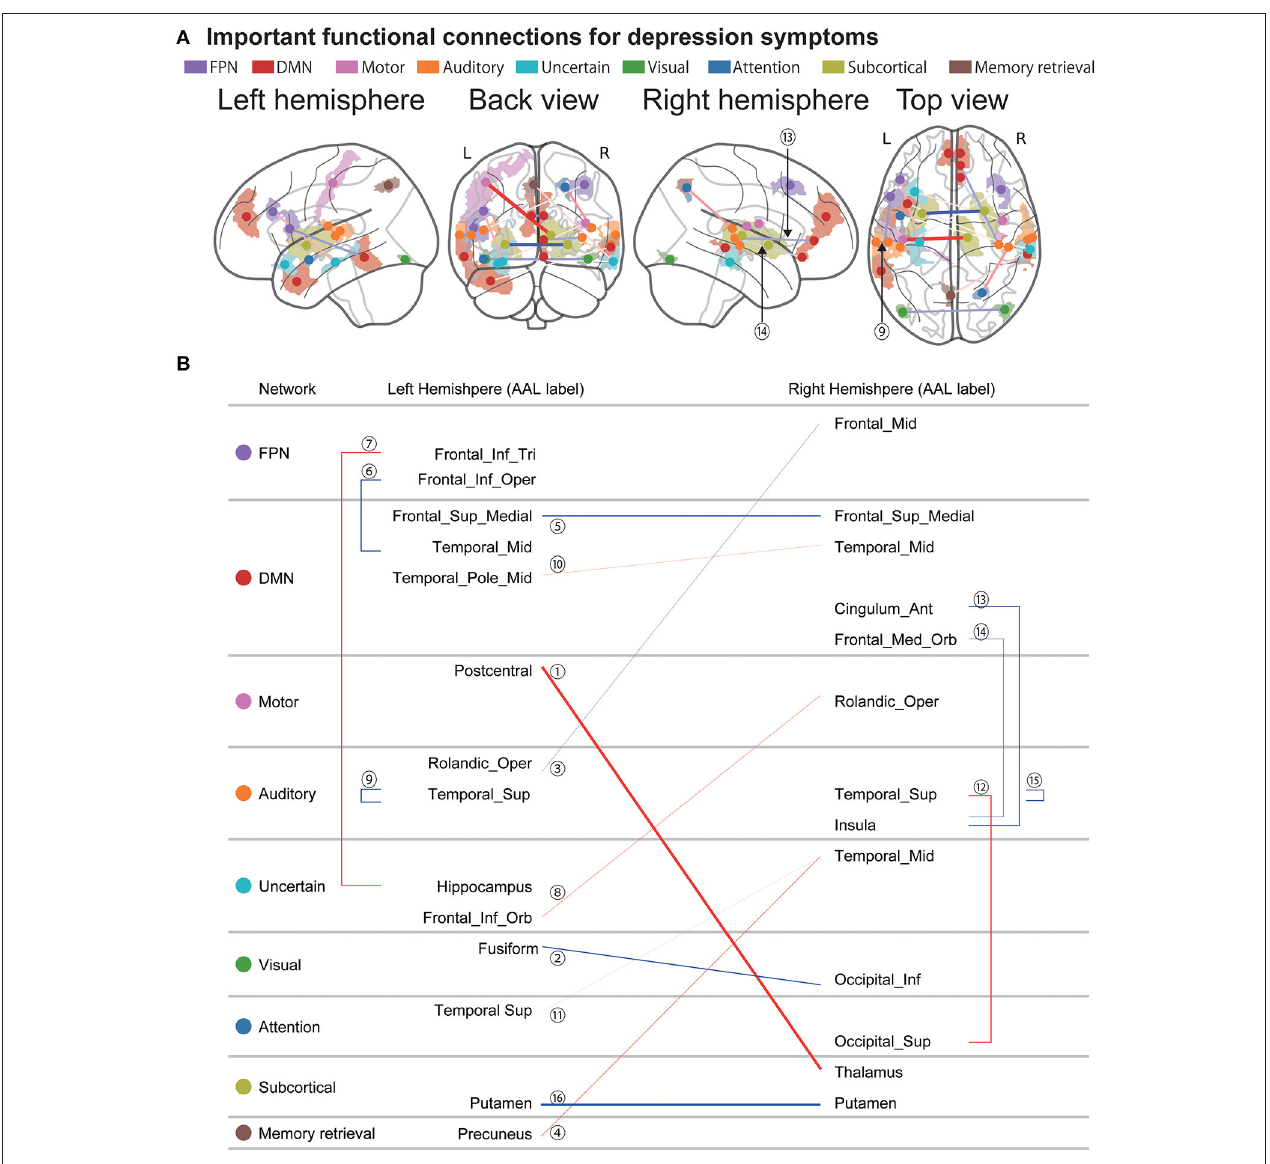
FIGURE 4 | Important FCs for depression symptoms. (A) The 16 functional connections (FCs) viewed from left, back, right, and top. Interhemispheric connections are shown in the back and top views only. Regions are color-coded according to the intrinsic network. The state of functional connectivity exhibits characteristics of the correlation with depression symptoms as follows. Thinner and thicker connections indicate weaker and stronger correlations with depression symptoms in the validation dataset. Blue and red connections indicate negative and positive correlations, respectively. (B) Listed here are the laterality and anatomical identification of the ROI, as identified by Anatomical Automatic Labeling (AAL) and associated intrinsic networks related to the 17 FCs. MDD, major depressive disorder; DMN, default mode network; FPN, fronto-parietal